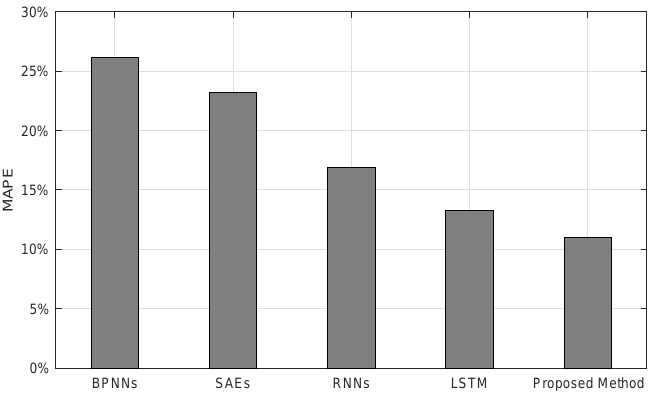
Figure 15. Compared average MAPEs trained and tested with all samples in three